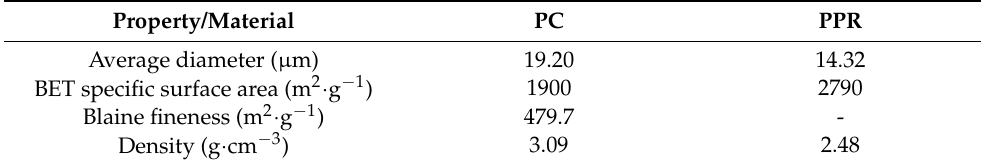
Table 1. Physical properties of the PC and PPR used.